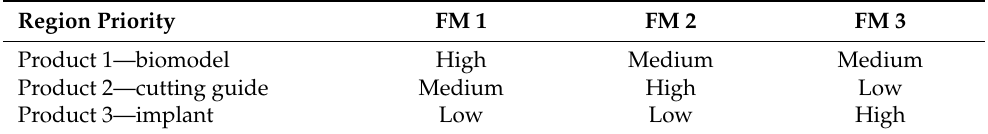
Table 5. Priority from scenario 1.